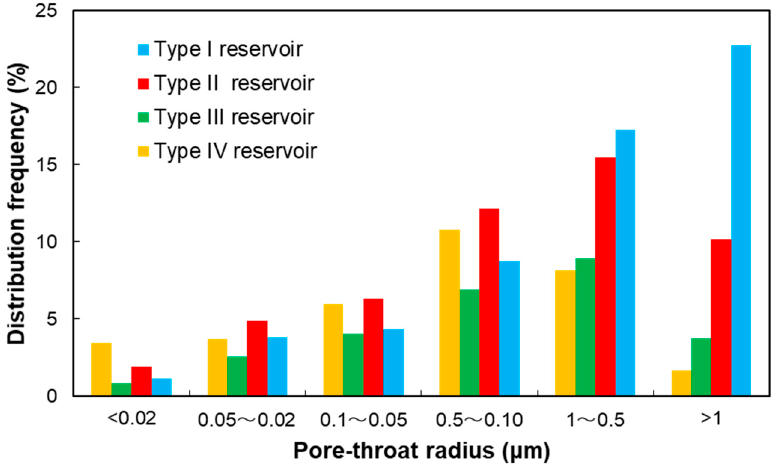
Figure 10. Frequency distribution of the pore throat radius of types of reservoirs .